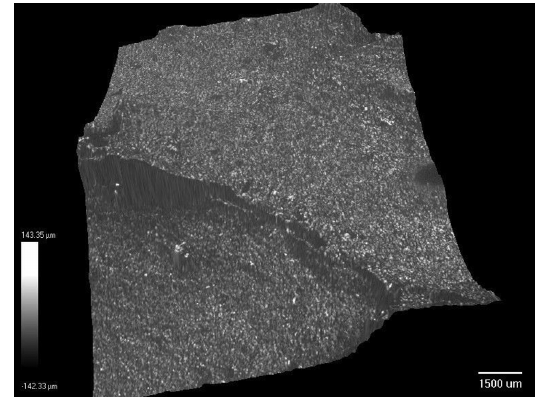
Figure 2. Samples of ceramic foams obtained for the two densities of polymers used as ceramic precursors: a) 1500 kg m -3 ; b) 1100 kg m -3 .